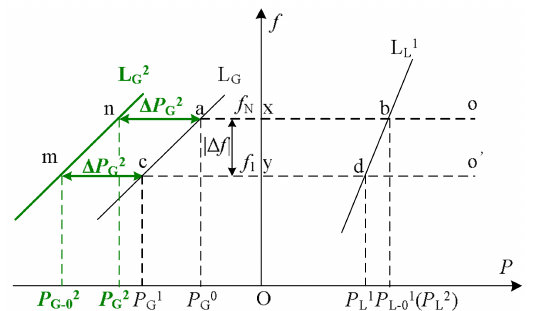
Figure 5. Schematic of secondary frequency regulation with S-L analysis method.